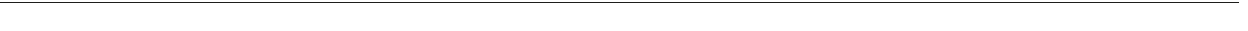
Fig. 2 myo1d is necessary for KV function and establishing laterality. a, b Relative abundance of dand5 expression on the right vs left were decreased in myo1d MZ mutants compared to WT embryos at 8S. c, d myo1d MZ mutants displayed laterality defects. Heart and gut looping scored by myl7 and foxa3 expression at 72 hpf respectively, spaw expression at 17S (white arrowhead marks expression). Laterality defects were scored in d . e, f myo1d MZ embryos display altered KV fl ow as analyzed by tracking 0.2 µ FITC fl uorescent microbeads injected into KV lumen. DIC images showing KV morphology of control and myo1d MZ mutants ( e ). Individual beads were mapped showing unidirectional circular movement were lost in myo1d MZ mutants compared to wild- type embryos. Individual bead movement was shown as temporal color-coded tracks. Graph comparing bead track velocity (mean ± SEM) in control ( n = 33 tracked beads from three embryos) and myo1d MZ mutant embryos ( n = 33 tracked beads from three embryos) ( f ). Unpaired t test indicate statistical signi fi cance * p < 0.05. Scale bar, 50 µ